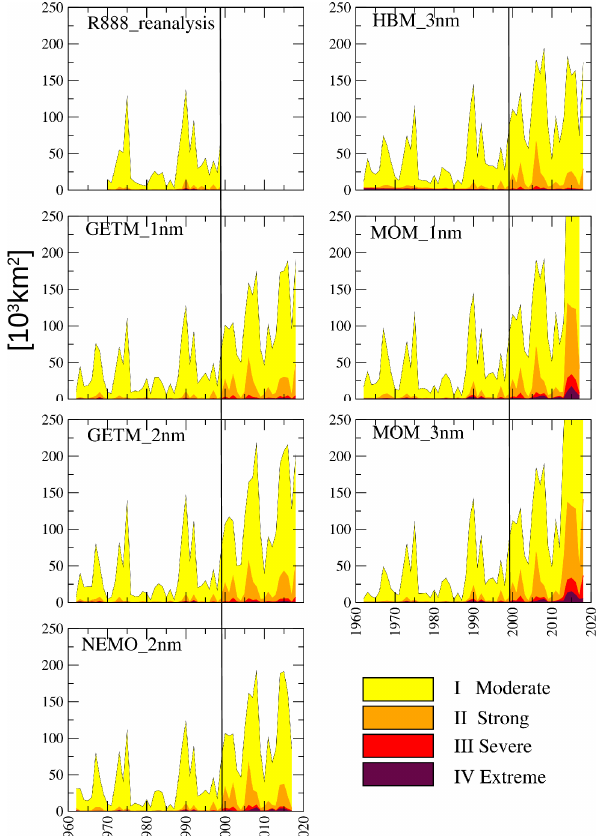
Figure 10. Yearly average spatial sea surface extent of MHWs over the entire Baltic Sea. The reanalysis data set refers to Liu et al. (2017). The vertical lines indicate the end of the reanalysis period in each panel. Classification was done after Hobday et al.